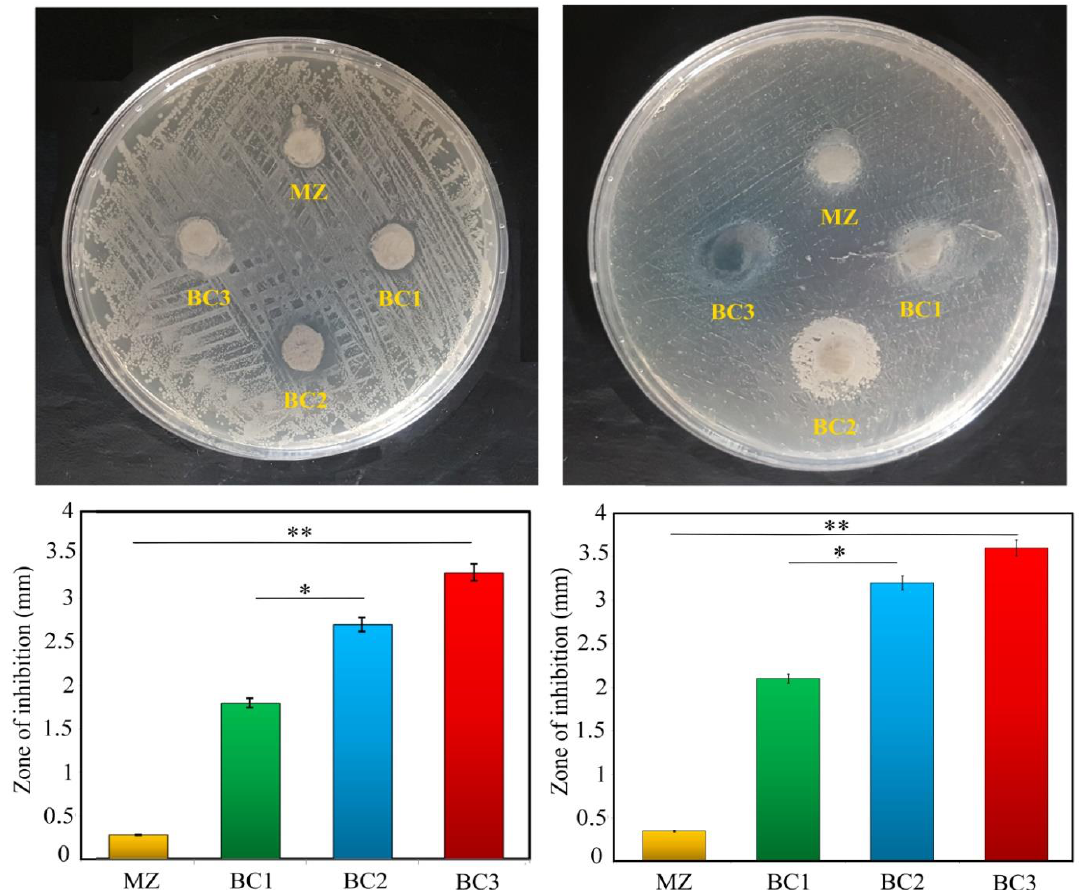
Figure 12. Antibacterial activity for different composites by disc diffusion method against Gram -positive bacteria and Gram-negative bacteria (* p ≤ 0.05, ** p ≤ 0.01). -positive bacteria and Gram-negative bacteria (* p ≤ 0.05, ** p ≤